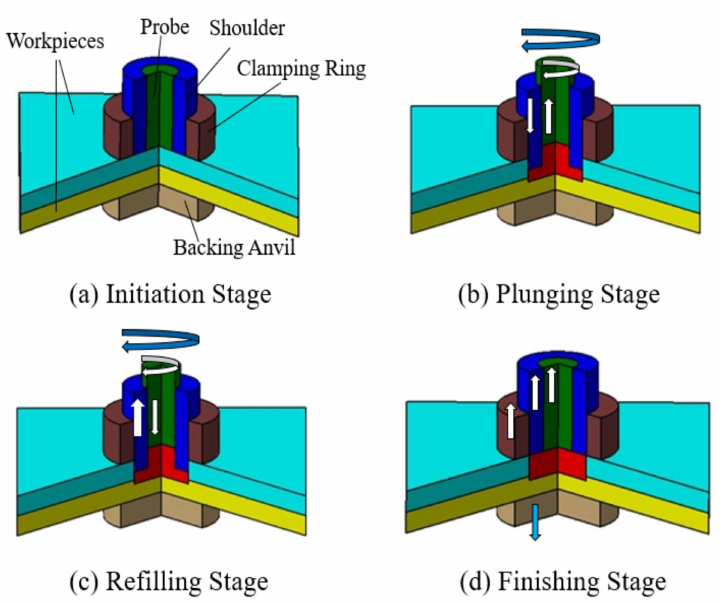
Figure 1. Refill friction stir spot welding (FSSW) process: ( a ) initiation stage—clamping of workpieces; ( b ) shoulder-plunging stage; ( c ) refilling stage; ( d ) finishing